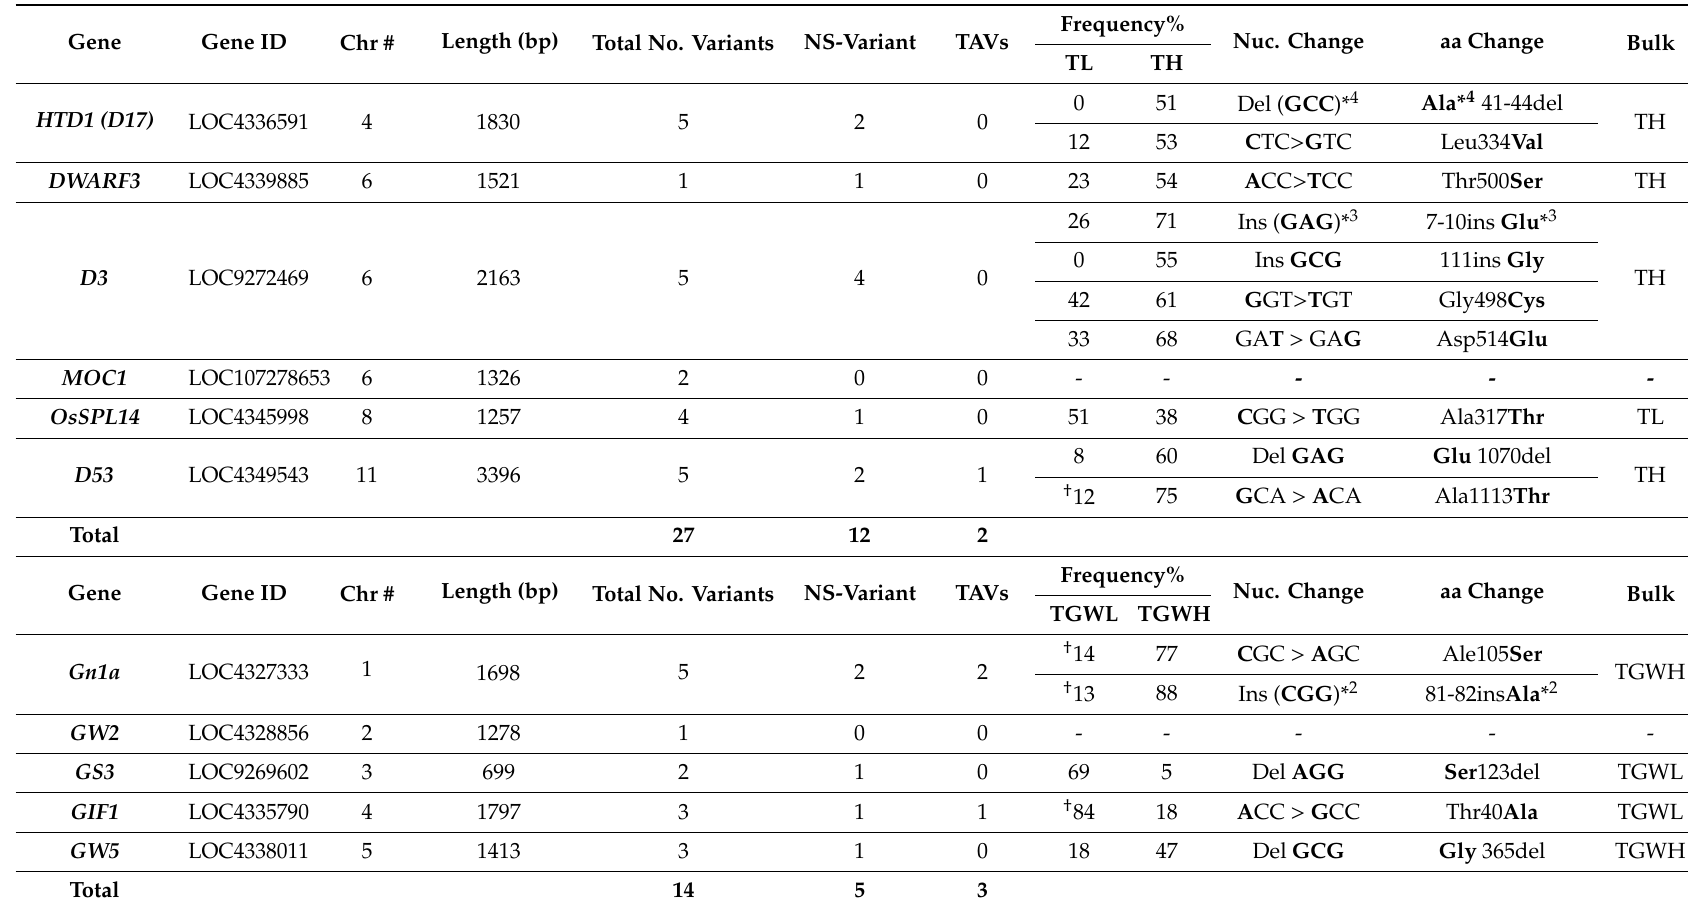
(HdL: heading date low, HdH: heading date high, TL: tiller low, TH: tiller high, TGWL: 1000 grain weight low, and TGWH: 1000 grain weight high) for Hd: heading date, T: tiller number at maturity, TGW: 1000 grain weight traits; † : TAVs met the requirements for verifying accuracy; DTH: days to heading, Hd: heading date, Ehd: early heading date, D: dwarf,